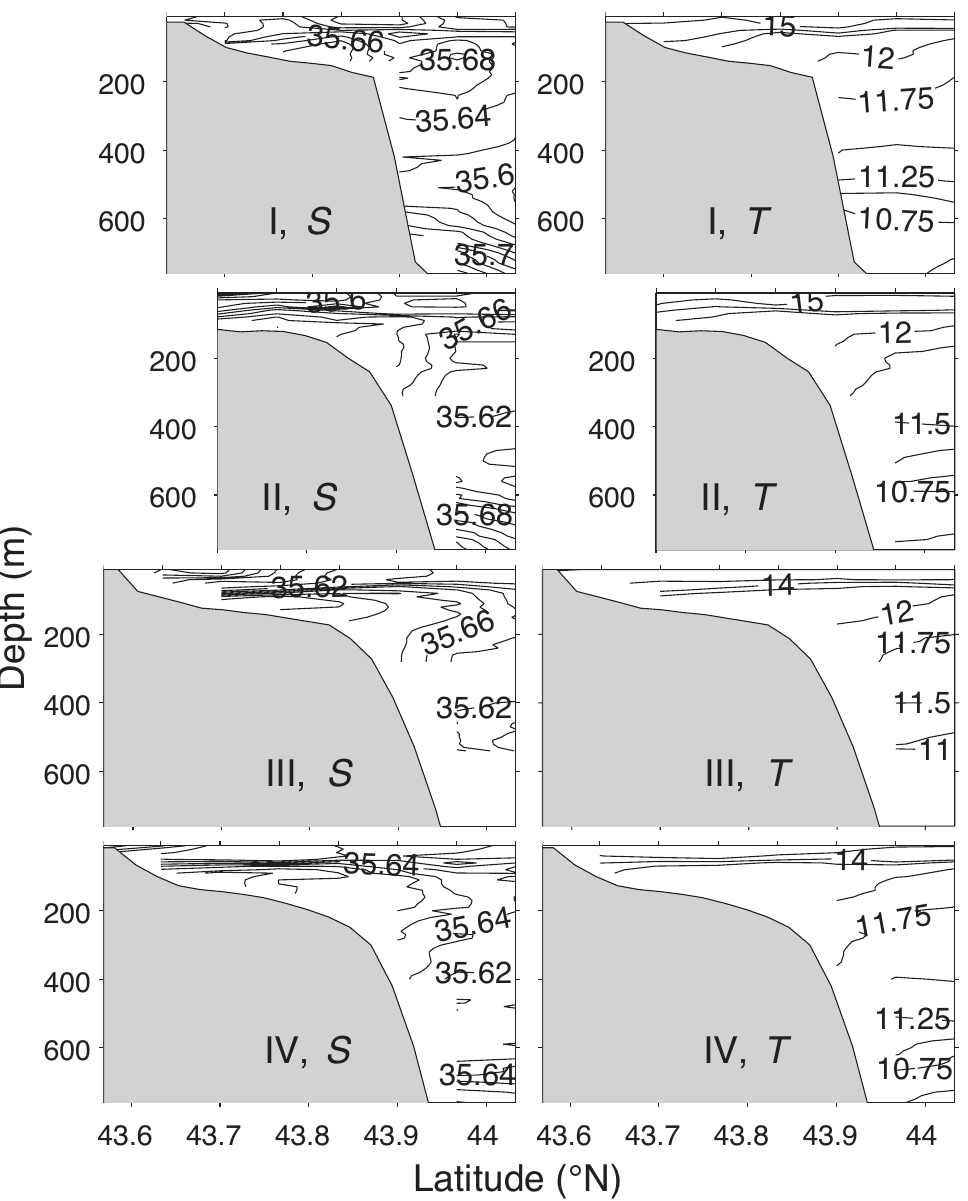
Fig . 10. – Salinity ( S , left) and temperature ( T , right) vertical sections during the ESEOO0506-I cruise as a function of latitude. Sections are numbered from west (upper row) to east (lower row) as shown in Figure